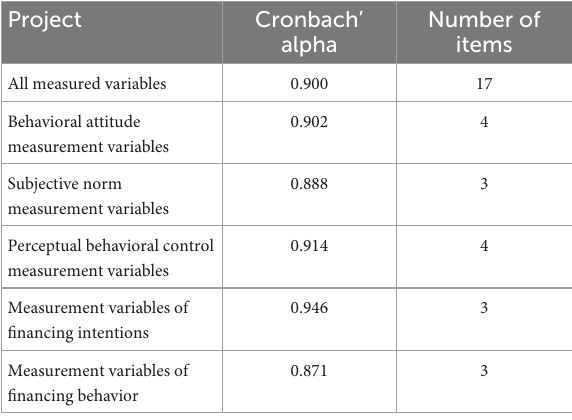
TABLE 3 Reliability statistics.